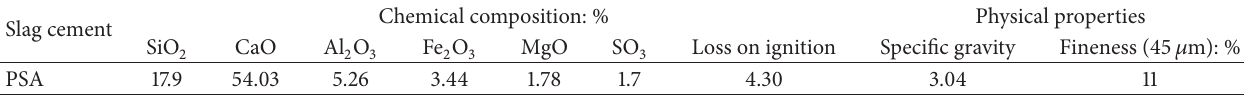
Table 1: Chemical composition and physical properties of slag cement.